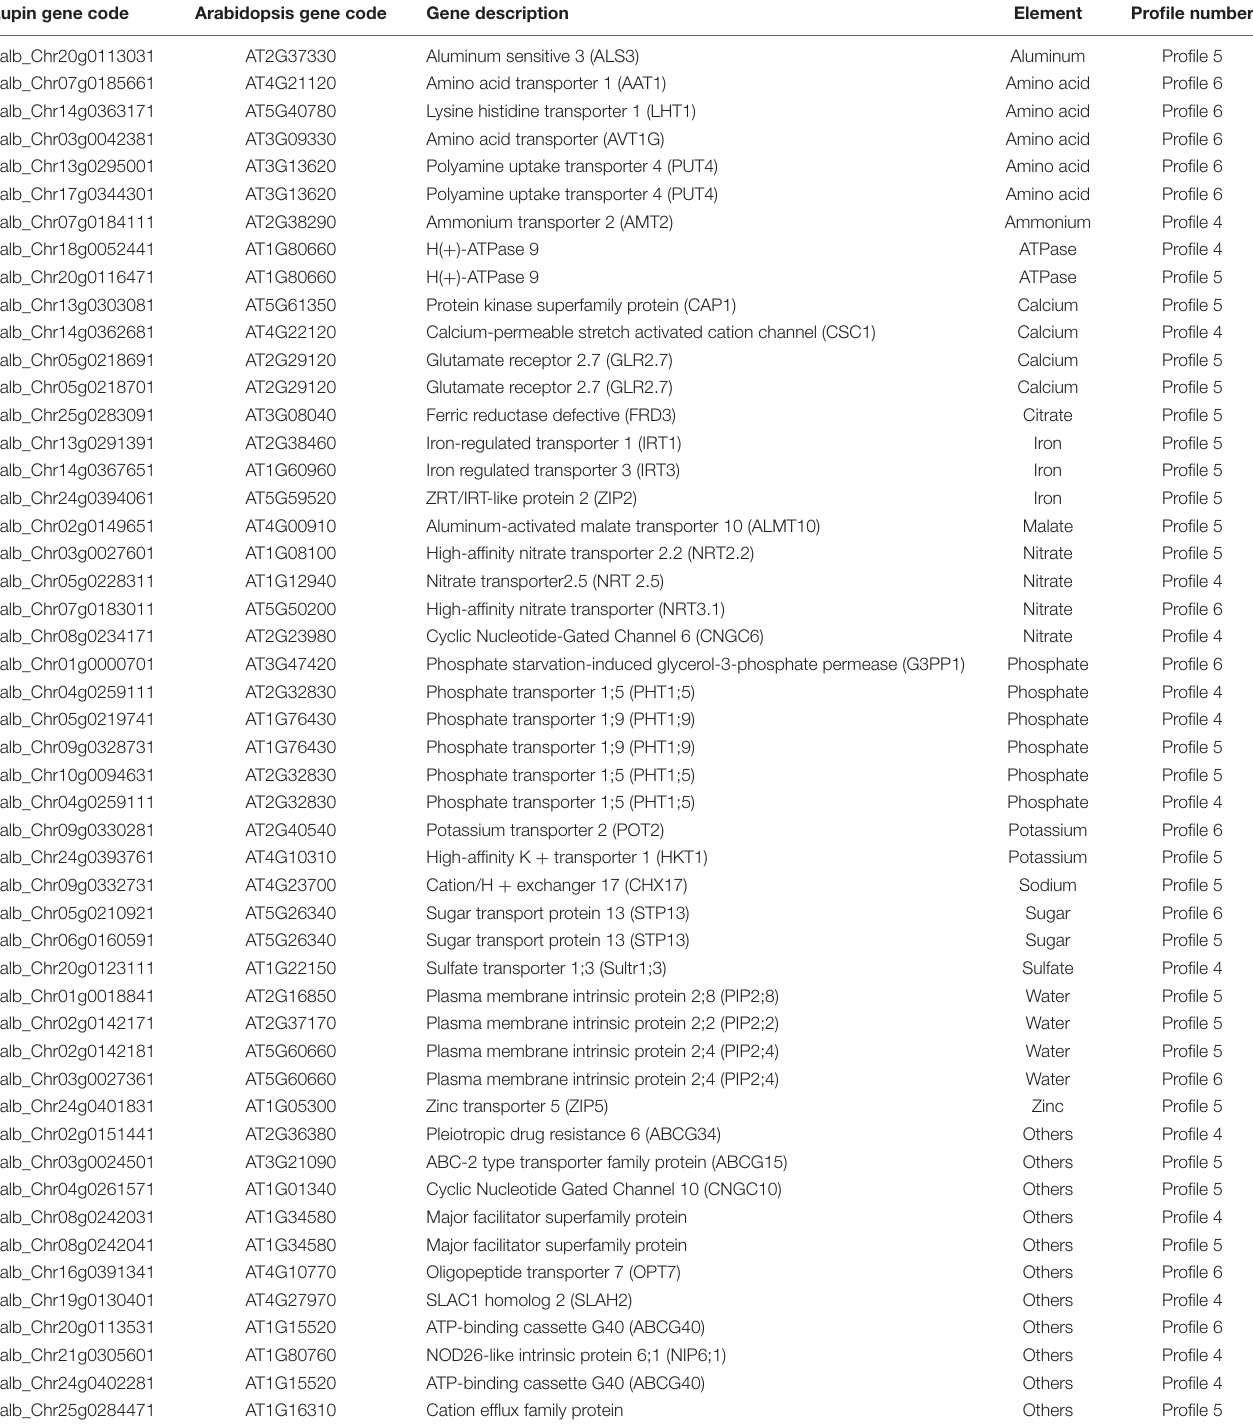
TABLE 1 | List of plasma membrane transport genes overexpressed in the late stages of rootlet development. Lupin gene code Arabidopsis gene code Gene